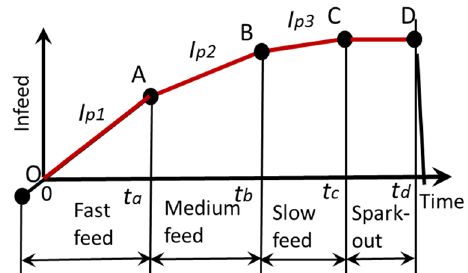
Figure 14. Setup of infeed grinding cycle.